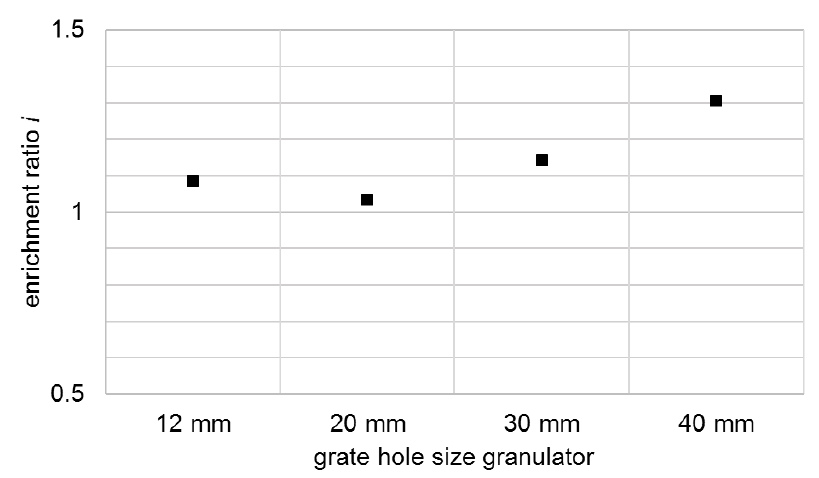
Figure 9. Enrichment ratio i of the anode coating in the comminution product shown for different grate hole sizes of the granulator. grate hole sizes of the